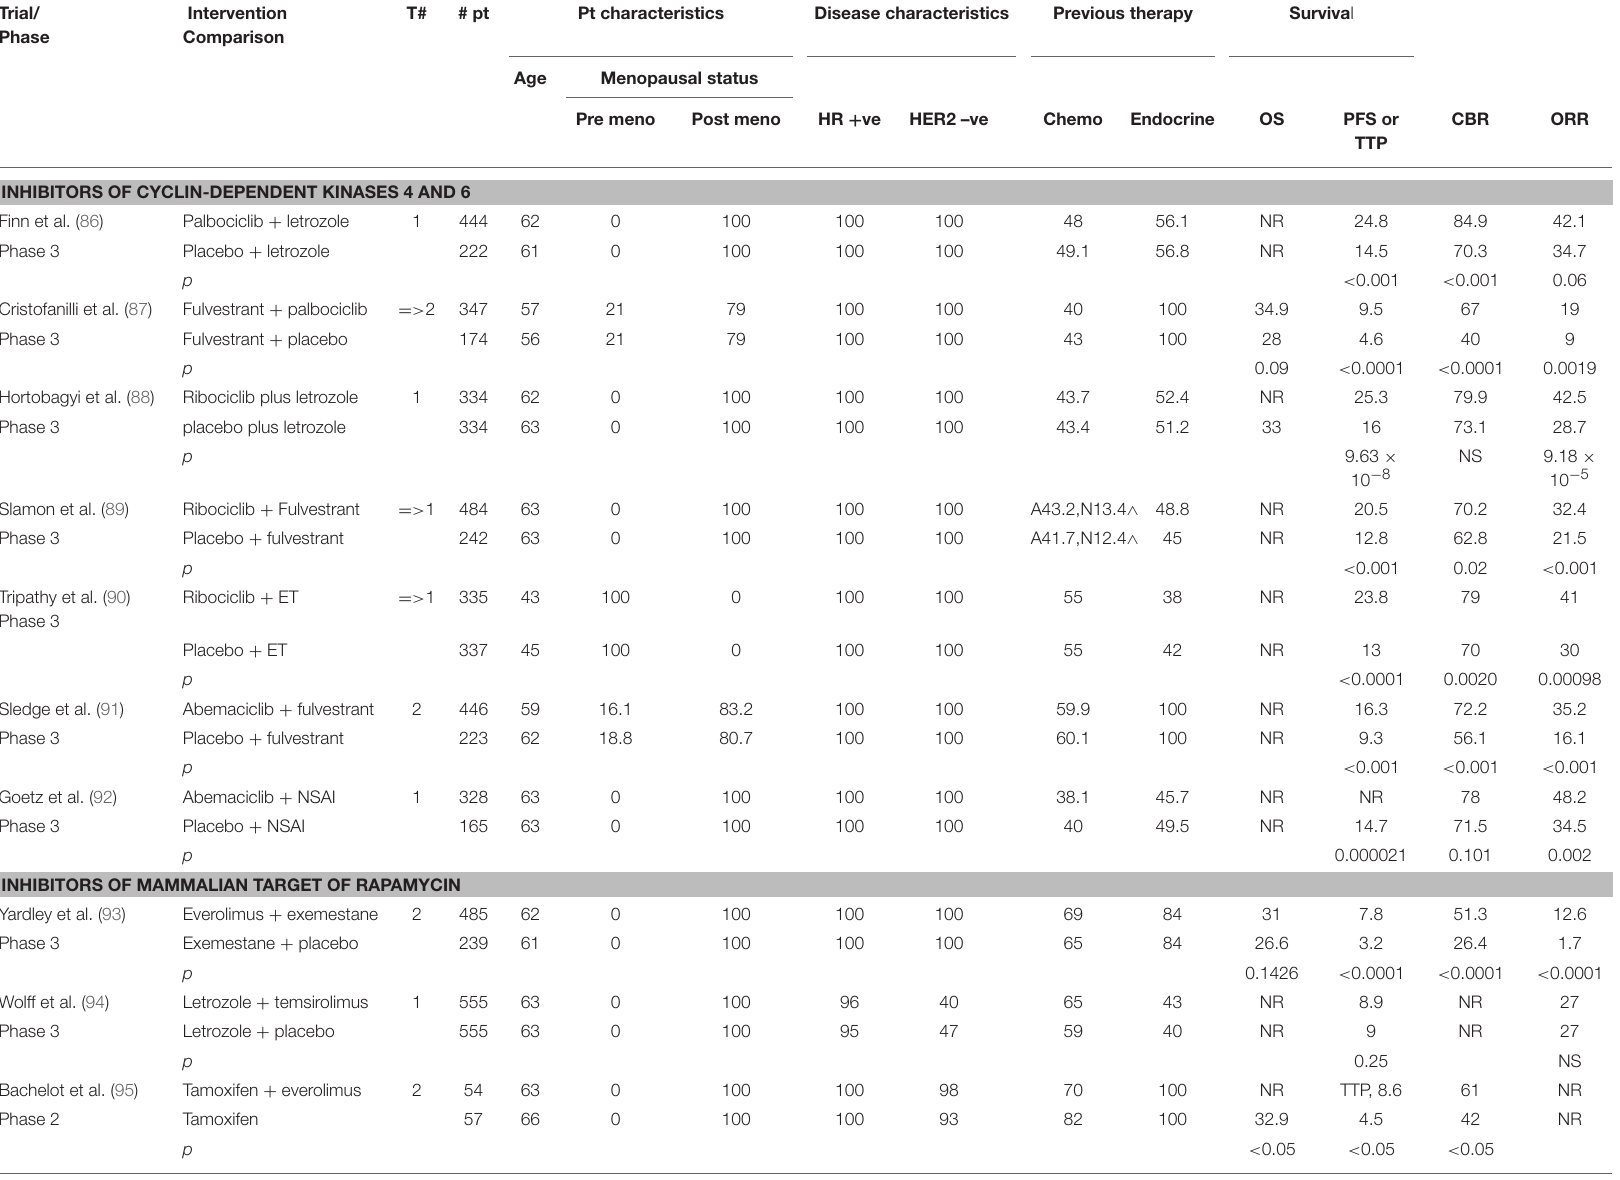
TABLE 2 | Overcoming resistance to endocrine